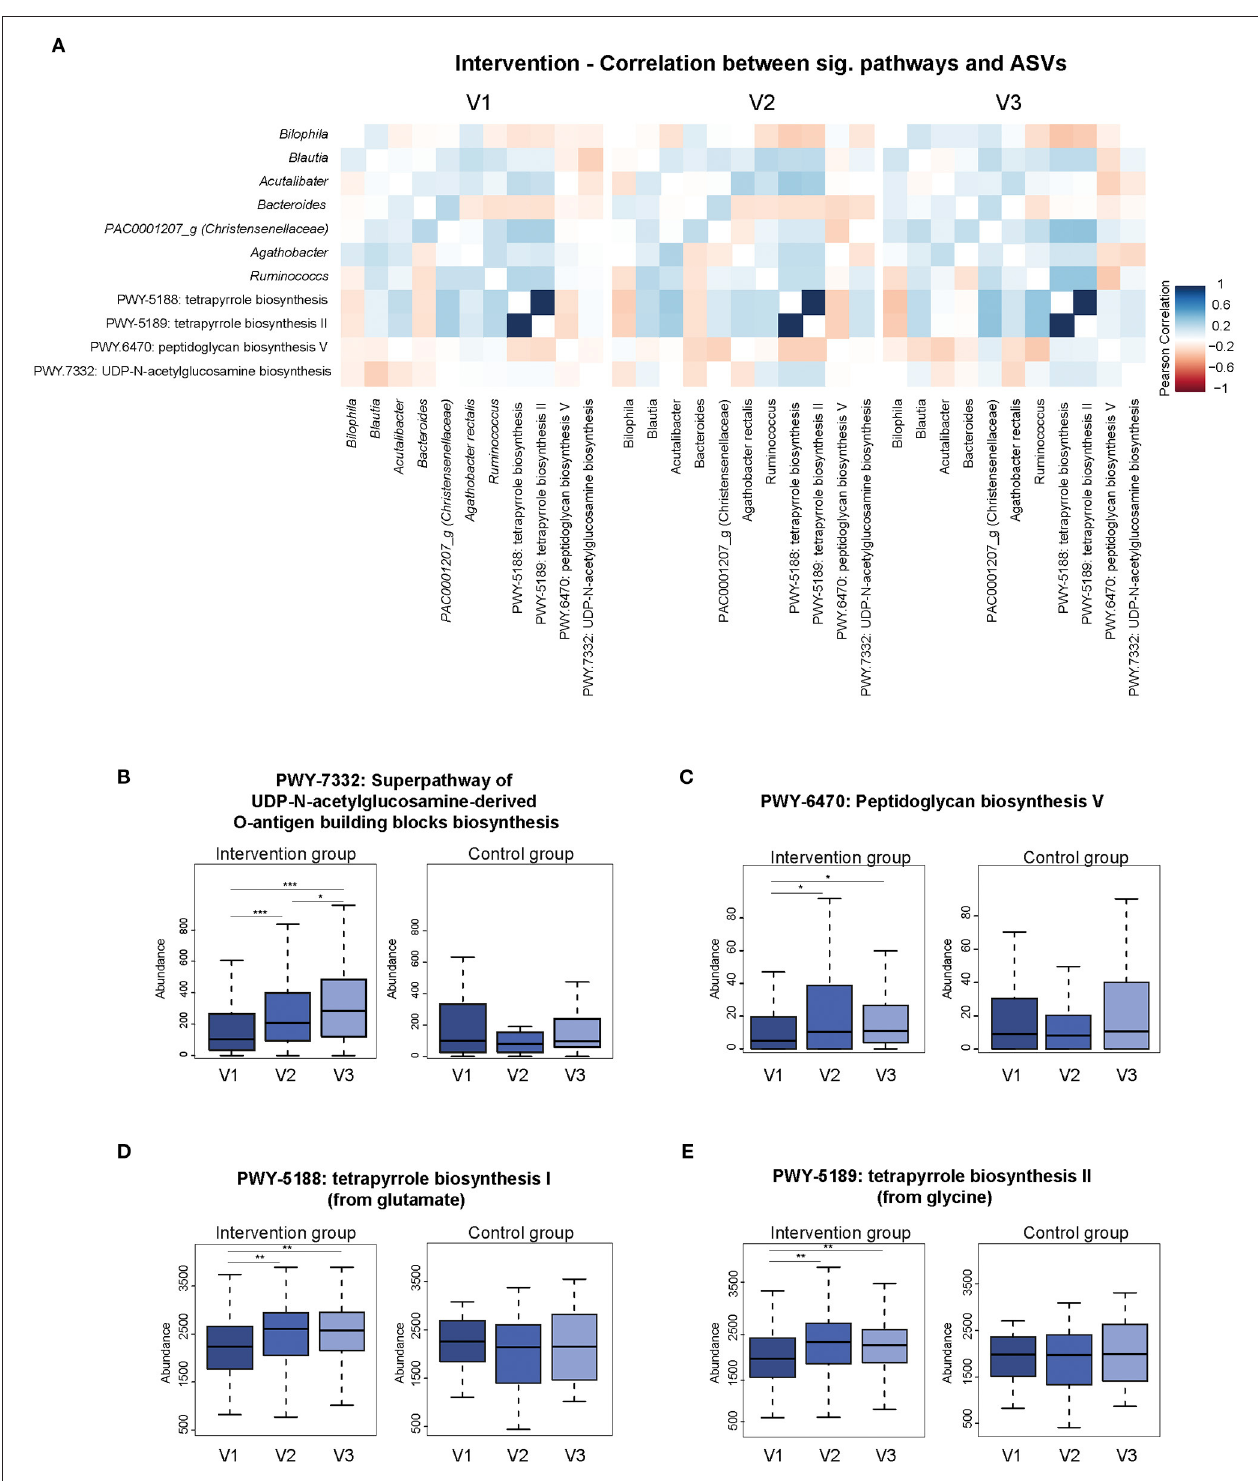
FIGURE 6 | The Association of predicted functional pathways and ASVs. (A) Predicted functional pathways (PiCRUST2) which are significantly different between visits in the intervention group. Heatmaps show significant correlation between selected pathways (Pearson’s R ≥ 0.3; Pearsons’s R ≤ − 0.3) and ASVs. Data was stratified according to visits. Strong negative correlations are shown in red and positive correlation are shown in blue. (B–E) Panels show significant differences in abundances of predicted pathways between visits within the intervention group compared to the placebo group. * p < 0.05, ** p < 0.01, *** p < 0.001.